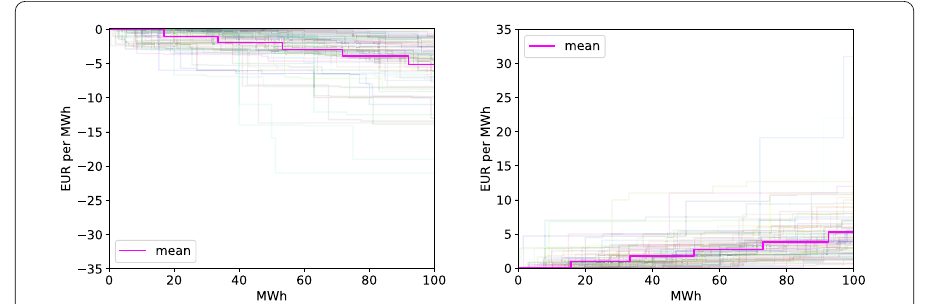
Figure 5 Cumulative volume on the different levels of the buy (left) and sell (right) order book and difference between price on an order book level and best price for all contracts in the sample. The thick red line reflects the mean cumulative volume and price difference on the different order book levels. Plots are cut off at cumulative volume of 100